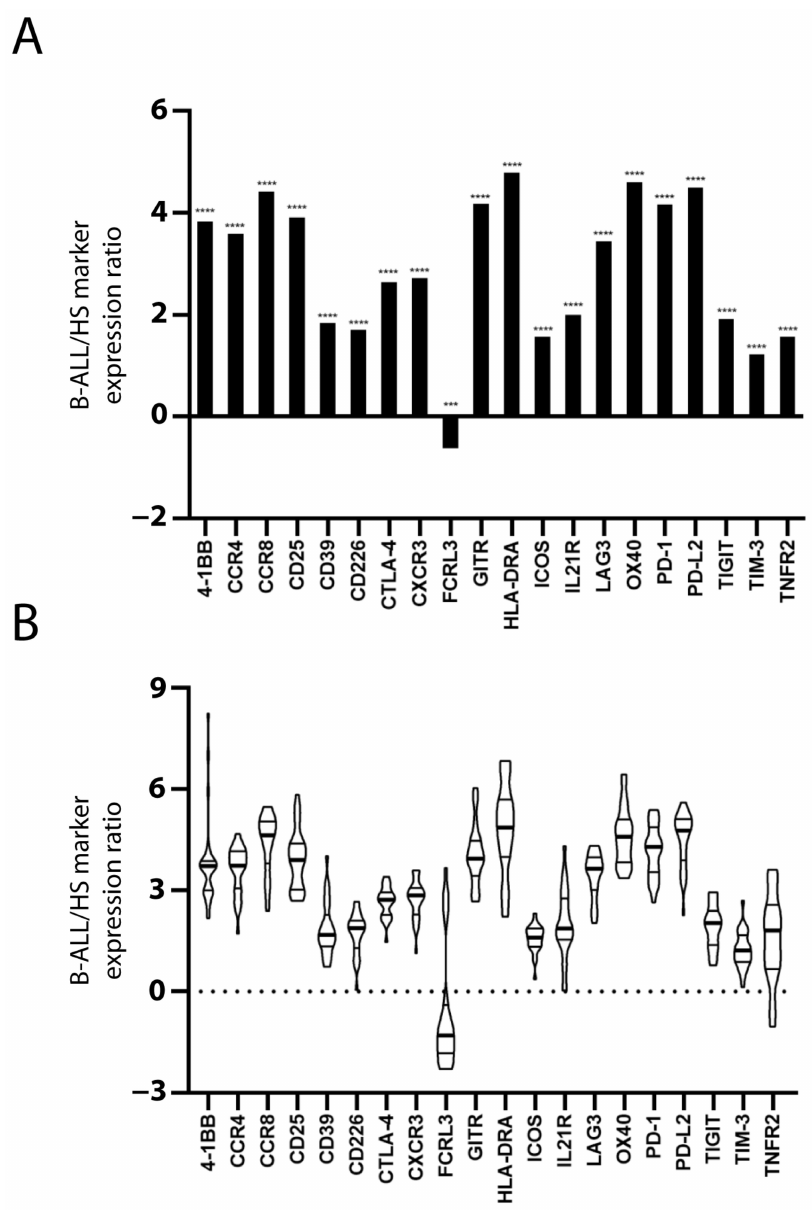
Figure 1. Increased Treg/CD8 exhaustion marker expression in patients with B-ALL. Treg/CD8 exhaustion marker expression (log2) in patient and healthy subject (HS) PBMC was normalized with the T cell signature (TCS) expression levels (log2). The mean normalized marker expression of patients minus HSs is reported (log2) ( A ). The significant difference between patients and HSs was evaluated using the t -test and Mann–Whitney test. *** p < 0.001 and **** p < 0.0001. The inter- patient variation of Treg/CD8 exhaustion marker overexpression is represented as violin plot ( B ). The distribution of data extends above the largest value and extends below the smallest value. The median (thicker line), and the 3rd and 1st quartiles are shown within the